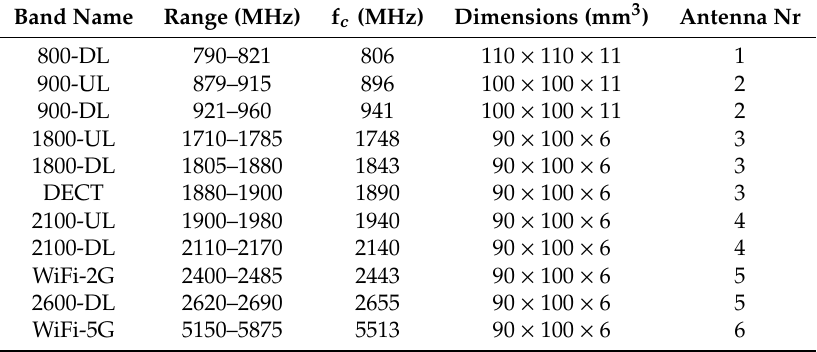
Table 1. Parameters of the designed textile antennas. f c : center frequency. Antenna Nr: antenna number; these numbers are shown in parenthesis in Figure 1.